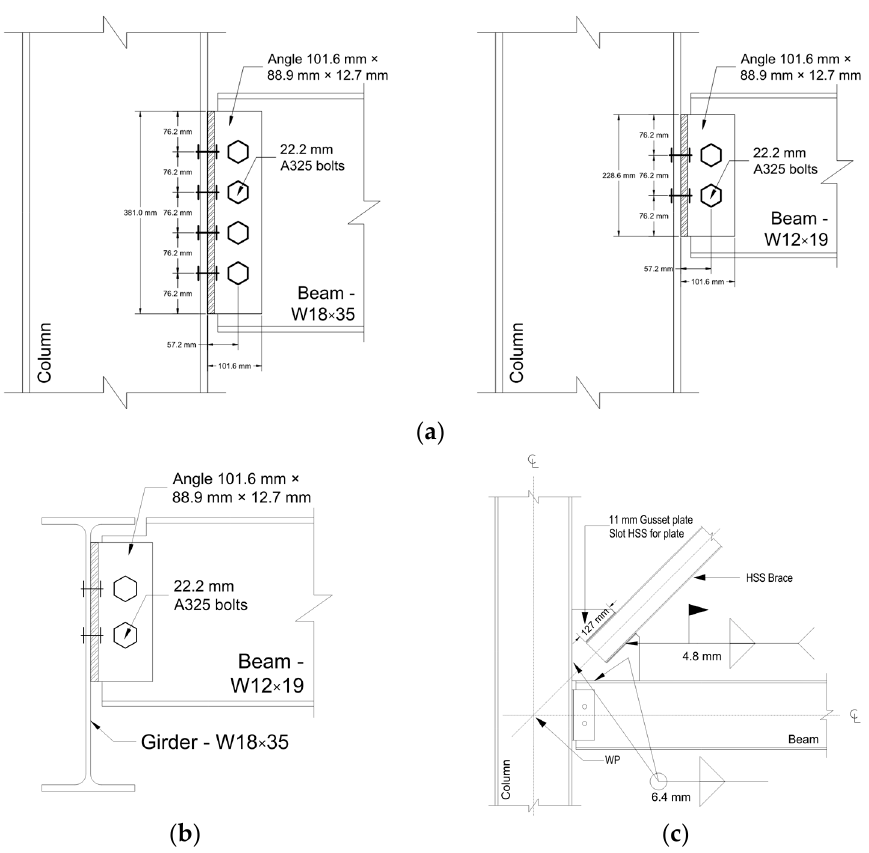
Figure 3. Details of structural connections between steel members: ( a ) Beam ‐ to ‐ column joints; ( b ) Girder ‐ to ‐ beam joint; ( c ) Gusset plate brace connection.